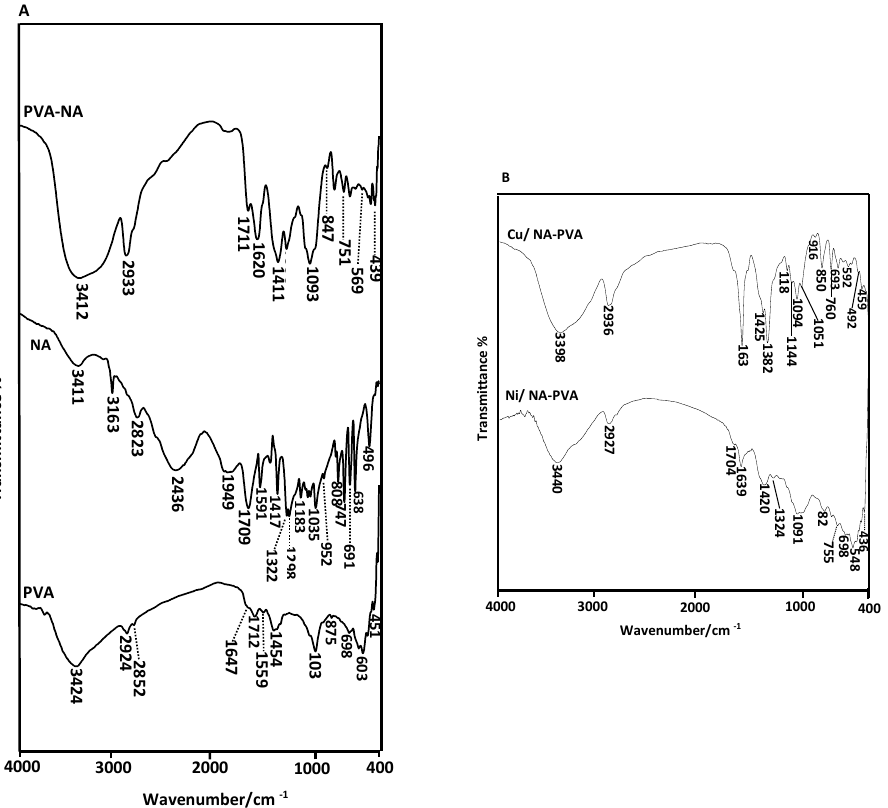
Figure 2. ( A ) FTIR translation spectra of PVA, NA and PVA-NA samples. ( B ) FT-IR translation spectra of Ni/PVA-NA and Cu/PVA-NA samples.